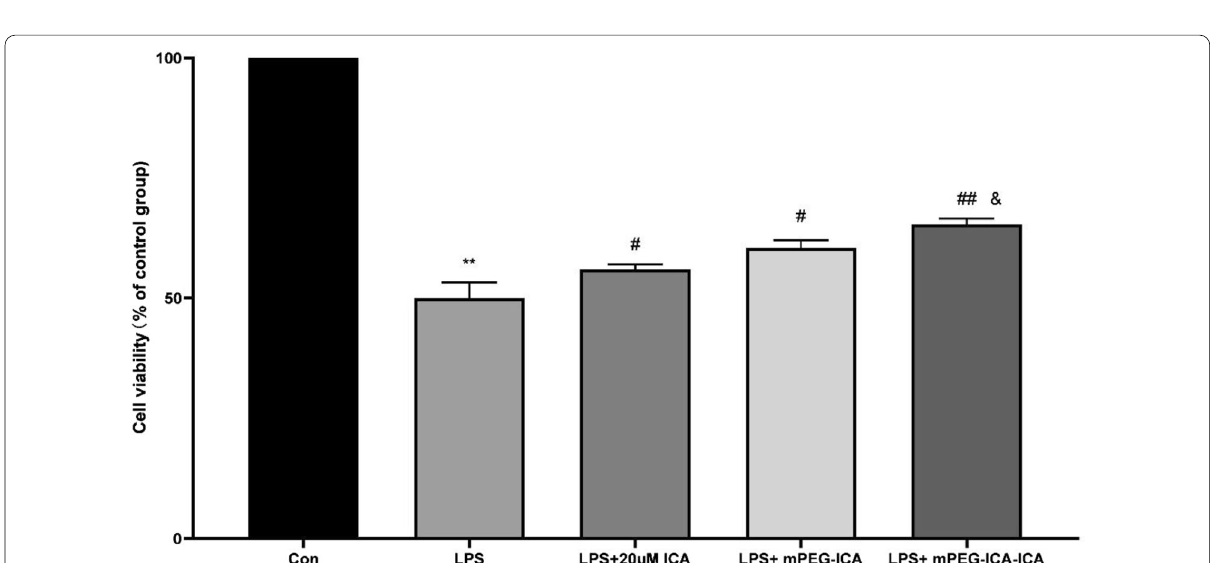
Fig. 6 Evaluation of the effects of ICA nanoparticles on LPS-induced H9c2 cell injury. Cell viability in different groups was measured by MTT assay. Data are the mean SME. (** P < 0.01 vs. con; # P < 0.05 and, ## P < 0.01 vs. LPS; & P < 0.05 vs . LPS ±